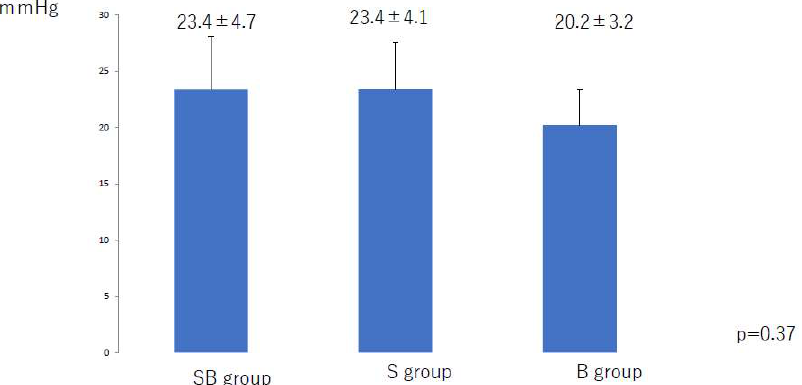
Figure 4. Mean compression applied to the lower leg after a decrease in pressure at 6 months after liposuction. B, bandage only; SB, compression stocking and bandage; S, stocking only.